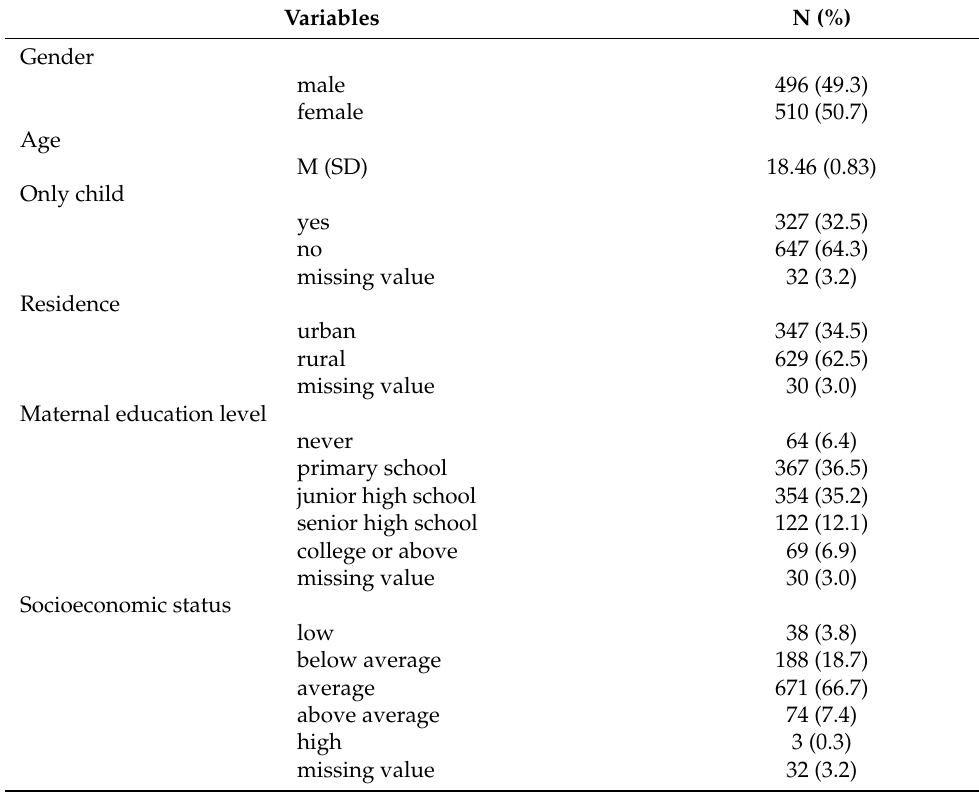
Table 1. Participants’ demographic